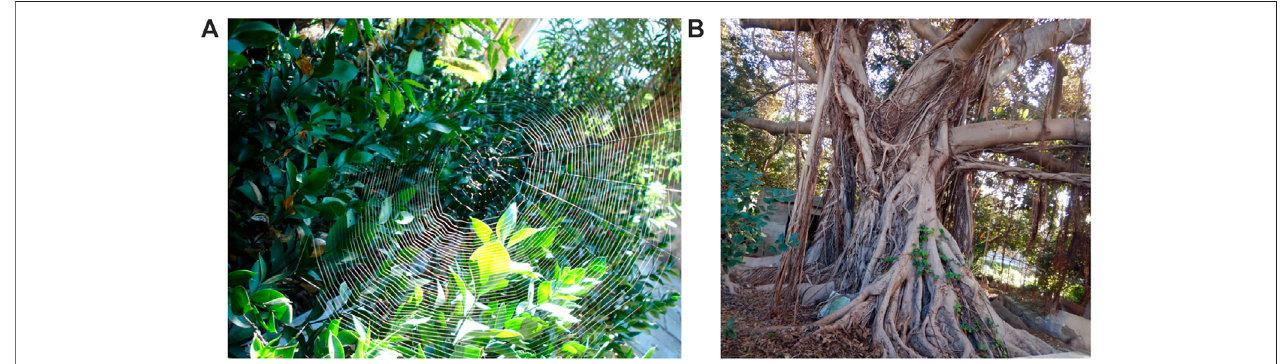
FIGURE 11 | Structures in nature: (A) a cobweb showing accurate regularity and (B) root system of a fi cus.